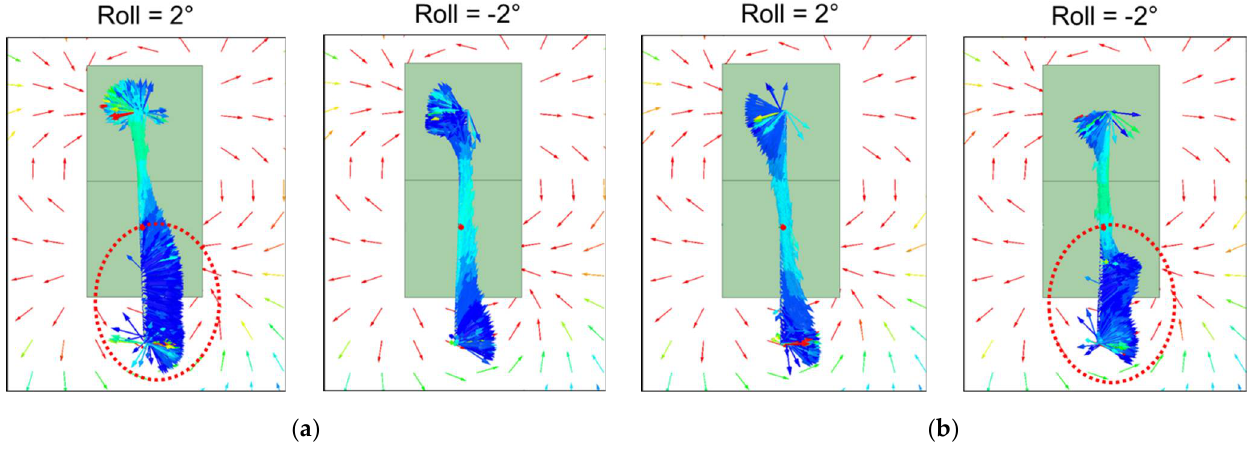
Figure 13. Simulation results of the magnetization direction of the Wiegand wire as indicated by colored arrows when δZ = 2 mm with Y being set at ( a ) −0.1 mm and ( b ) 0.1 mm, respectively. The red-circled regions highlight region of the wire when ratio of the magnetization direction in the radial axis increases due to the wire’s soft layer suddenly reverses its polarity.